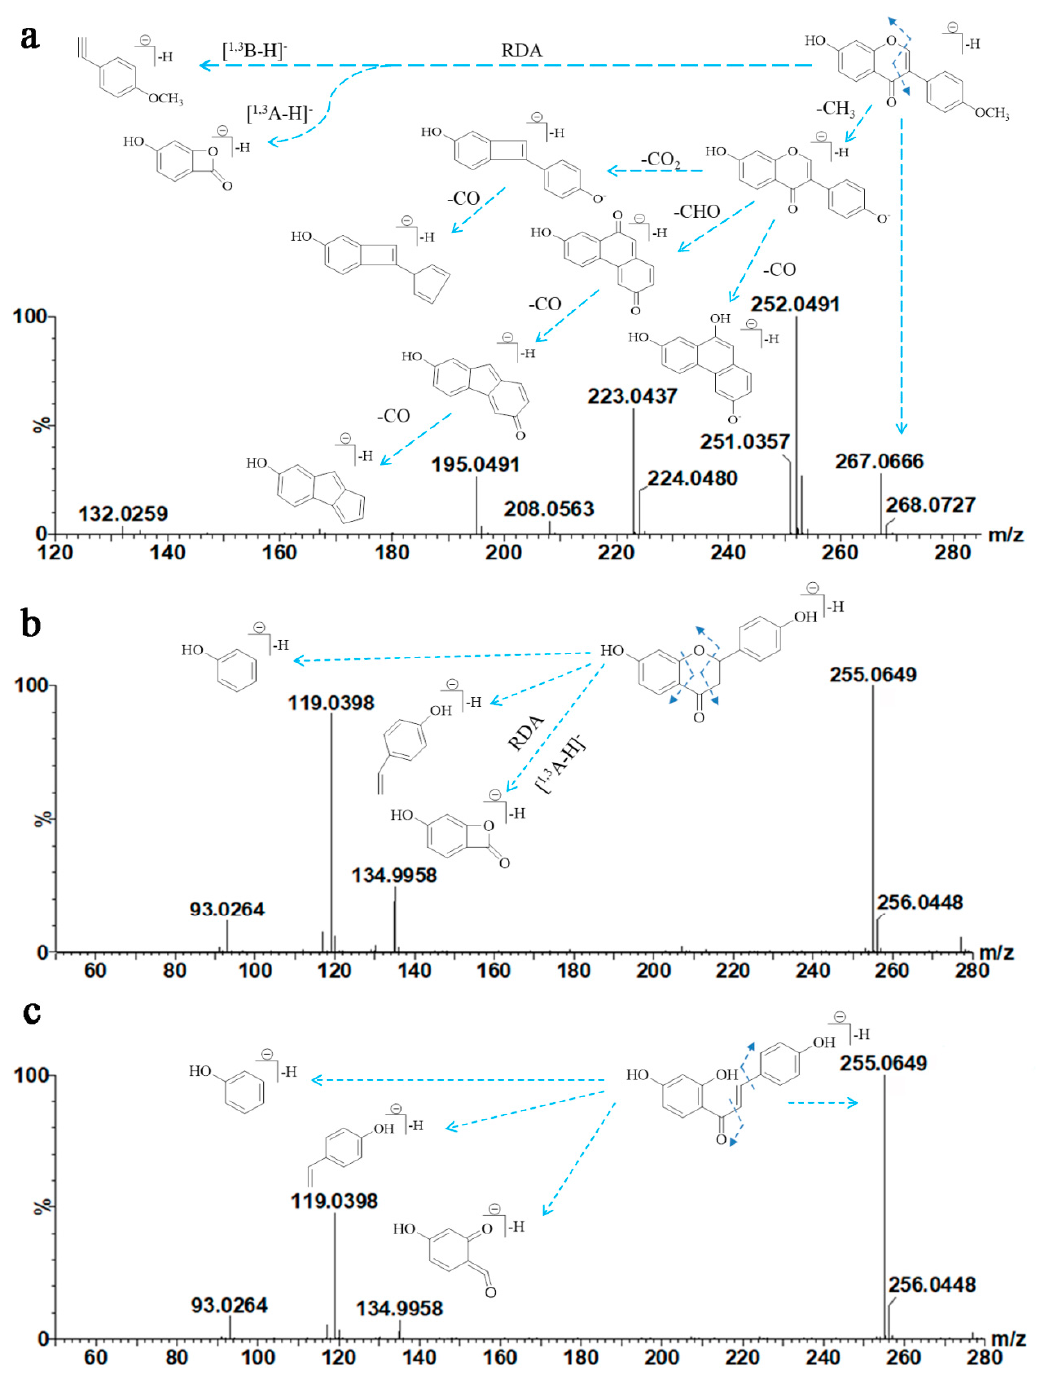
Figure 4. MS/MS spectra and the proposed fragmentation pathway of formononetin ( a ), Figure 4. MS / MS spectra and the proposed fragmentation pathway of formononetin ( a ), liquiritigenin liquiritigenin ( b ), and isoliquiritigenin ( c ). ( b ), and isoliquiritigenin ( c